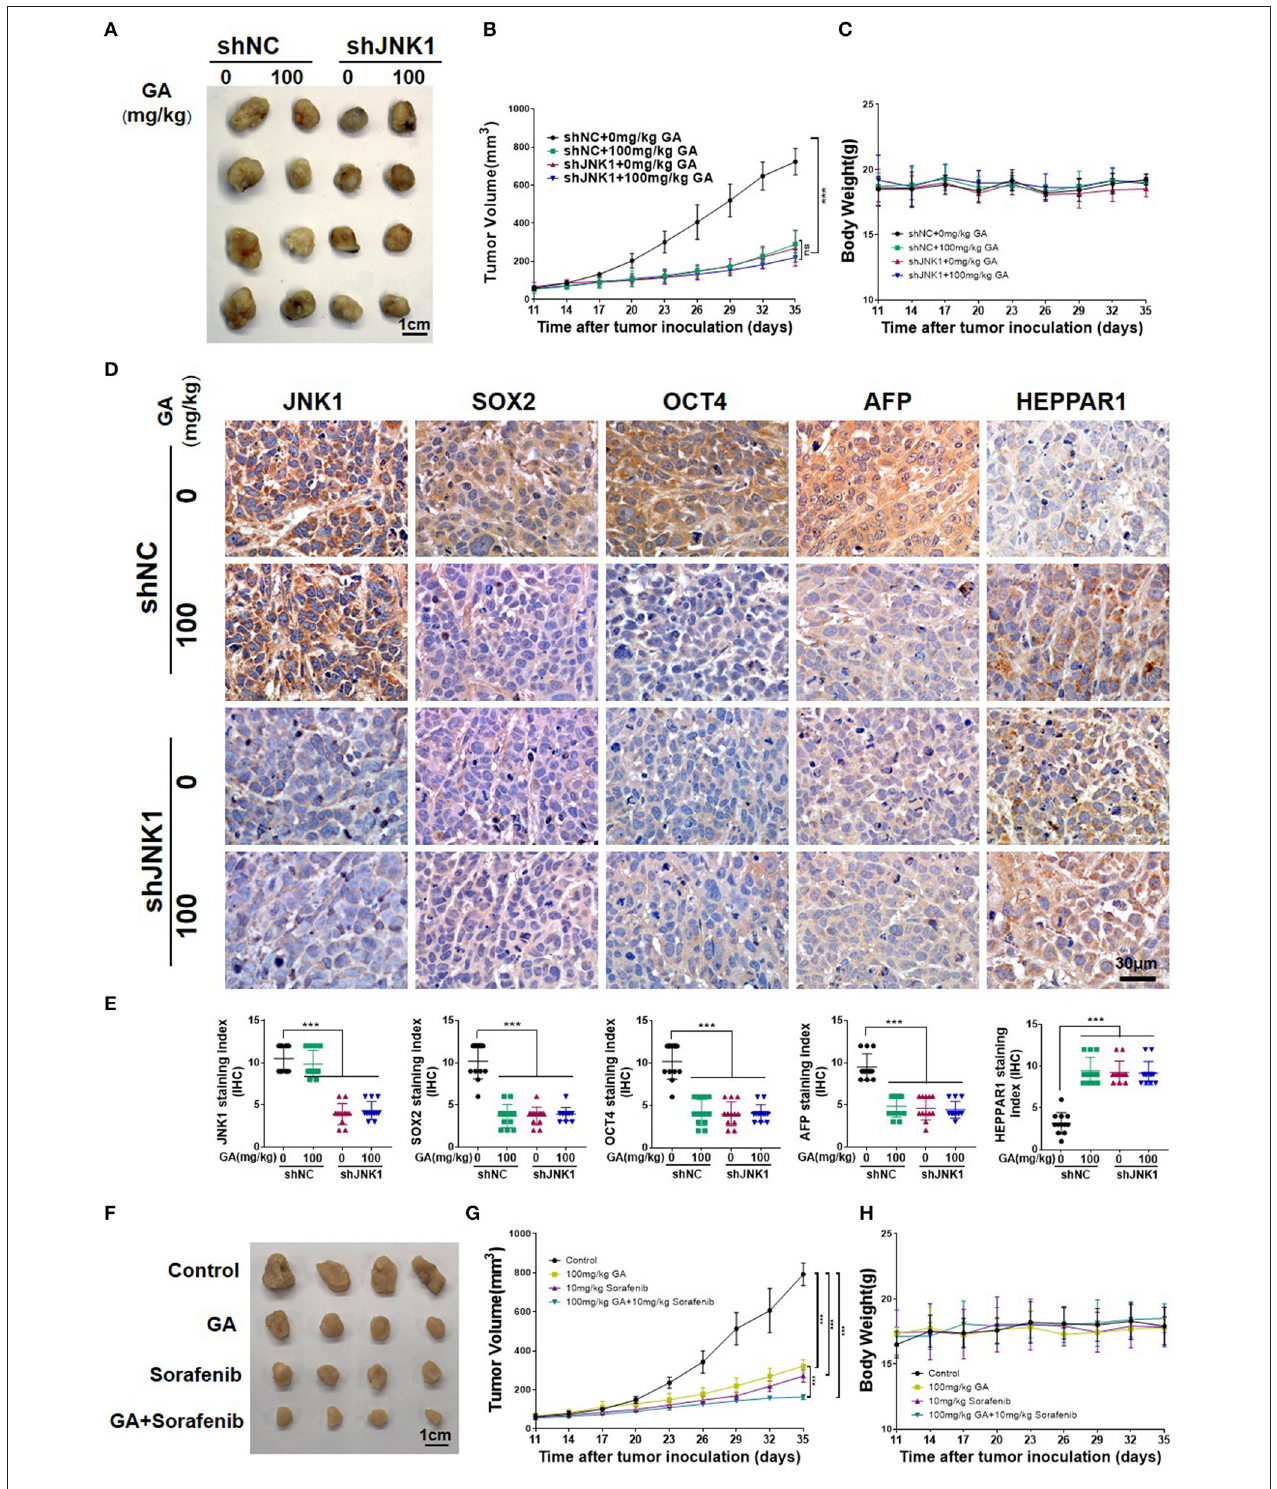
FIGURE 6 | GA suppresses tumor growth and enhances the antitumor effect of sorafenib. Images of tumors (A) , tumor volumes (B) , and body weight (C) of PLC/PRF/5 transfected with shNC or shJNK1 in BALB/c nu/nu mice treated with 100 mg/kg GA or saline as control. (D) IHC staining indicates the expression of CSC markers (SOX2 and OCT4) and differentiation markers (AFP and HEPPAR1) in tumors. (E) IHC analysis of SOX2, OCT4, AFP, and HEPPAR1 in tumors (one-way ANOVA; *** P < 0.001). Scale bars in (D) , 30 µ m. Images of tumors (F) , tumor volumes (G) and body weight (H) of PLC/PRF/5-bearing BALB/c nu/nu mice. GA or sorafenib treatment obviously inhibited tumor growth. Furthermore, GA could enhance the anti-tumor effect of sorafenib.